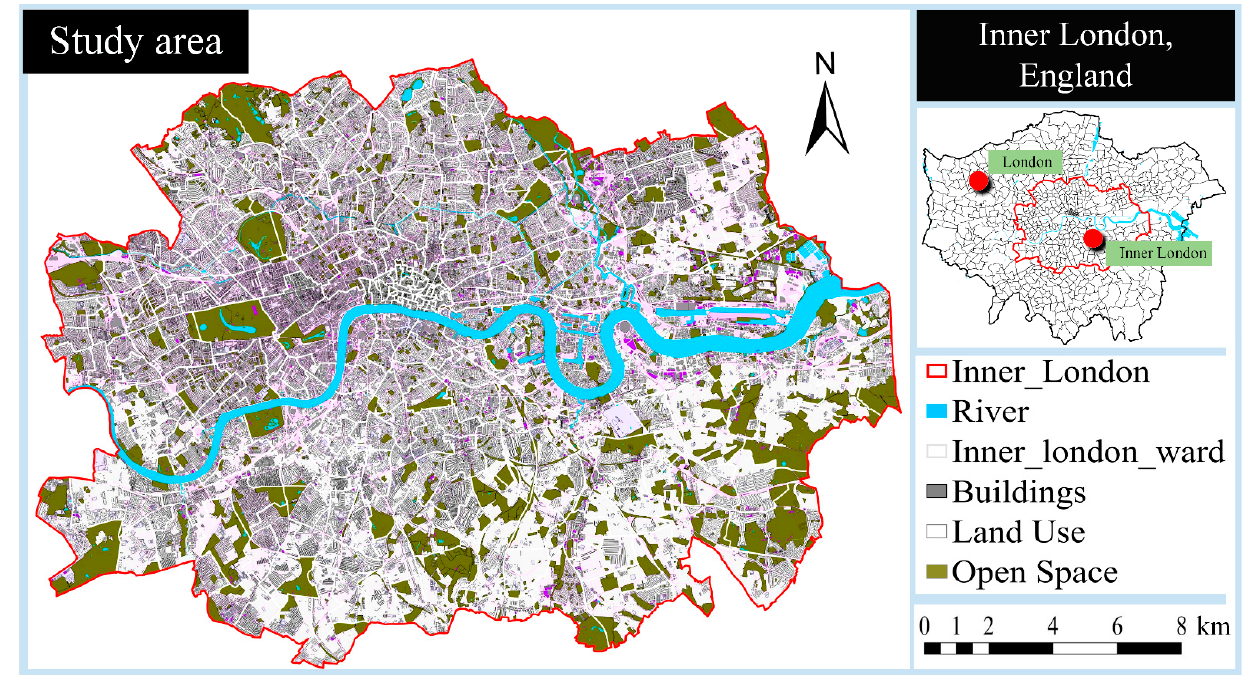
Figure 1. The extent of the study area, Inner London, England.